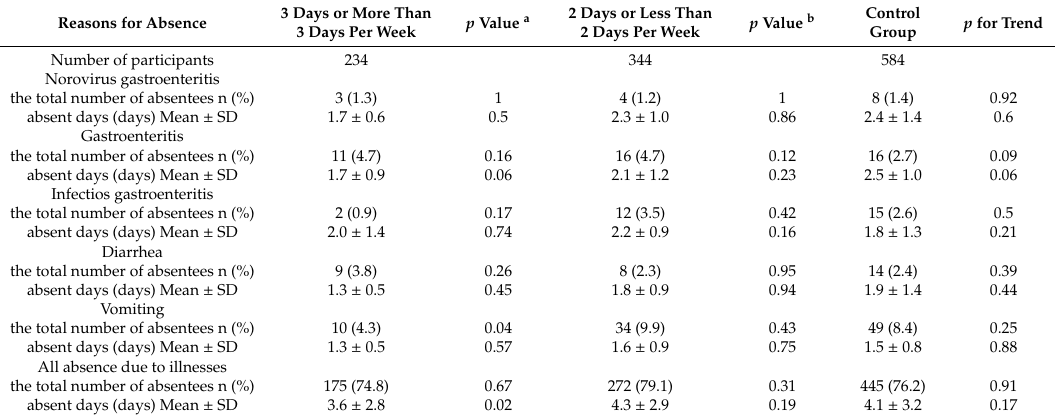
Table 3. The numbers of absentees and absent days in LF( < 3 days / week) group, LF(3 days / week ≤ ) group and Control group.